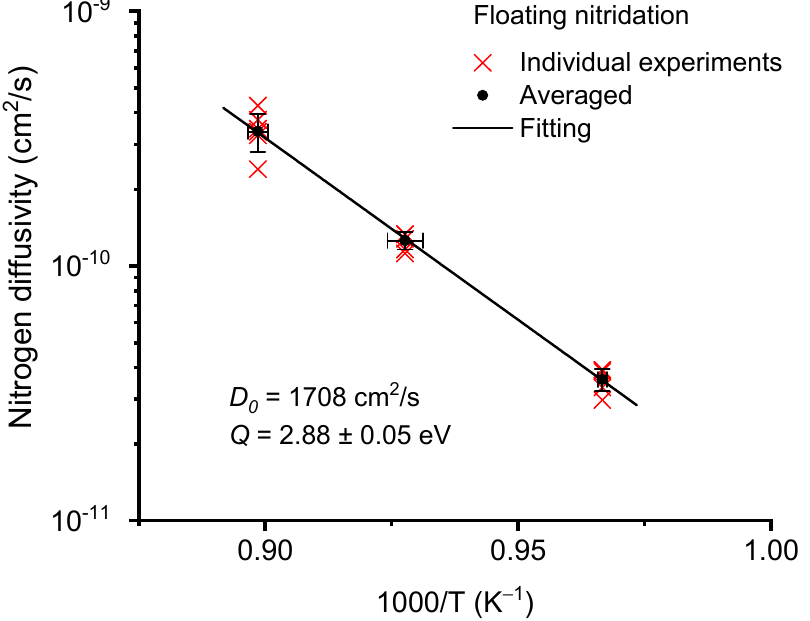
Figure 9. Arrhenius plot of nitrogen diffusivity in Zircaloy-4 as a function of nitridation temperatures for floating nitridation.